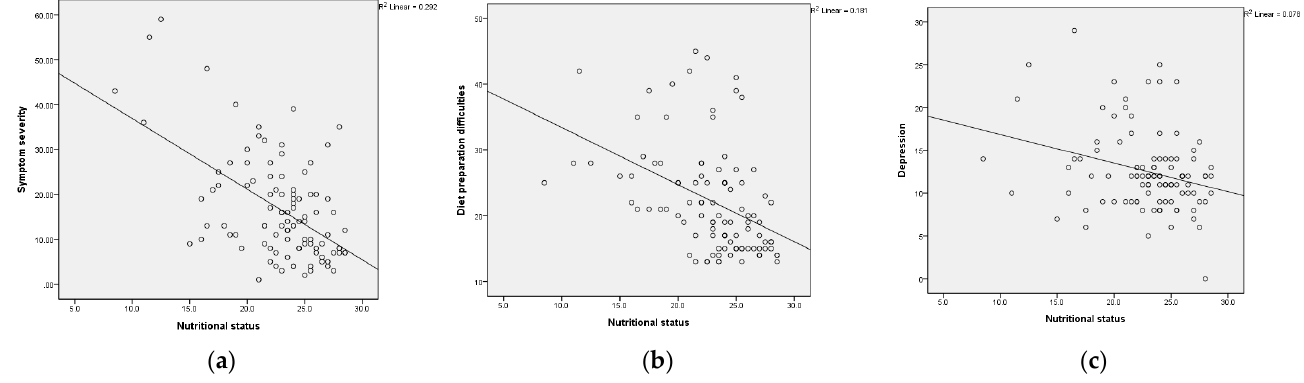
Figure 1. Scatterplot of ( a ) nutritional status with symptom severity; ( b ) nutritional status with diet preparation difficulties; ( c ) nutritional status with depression severity.